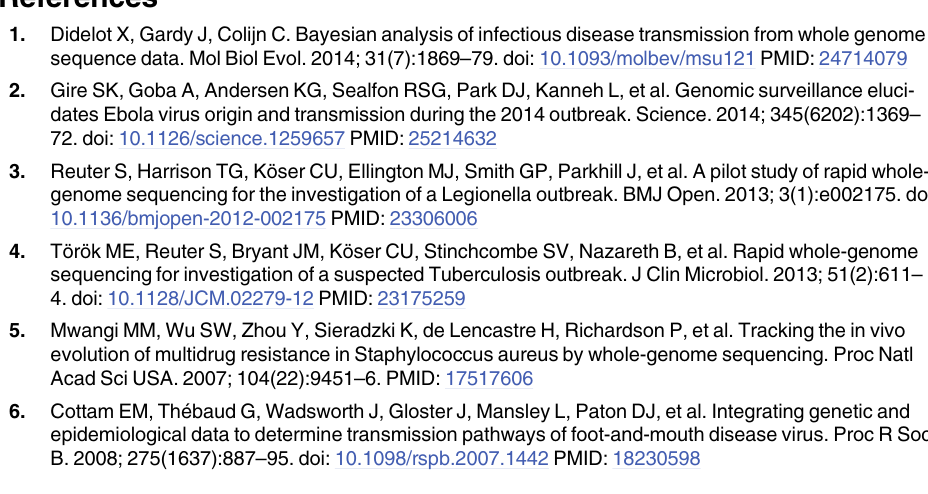
distribution (shown in grey), allowing direct transmission to be ruled out to this probability level. S2 Fig. The true transmission network (top left), corresponding to the outbreak shown in Fig 2. The network was estimated based on simulated genomic samples using the transroutes() function, and the estimated network weighted by posterior probability (top right) and the max- imum likelihood transmission routes (bottom left) are shown. For comparison, the network es- timated under the assumption that the host carrying the closest genotype is the source of infection is also shown (bottom right). S3 Fig. Computational times for simulating an outbreak under a variety of parameter set- tings (initial number susceptible population, mutation rate) using the function simula- teoutbreak(). Computer specifications: 2.7 GHz Intel Core i5, memory 8GB.